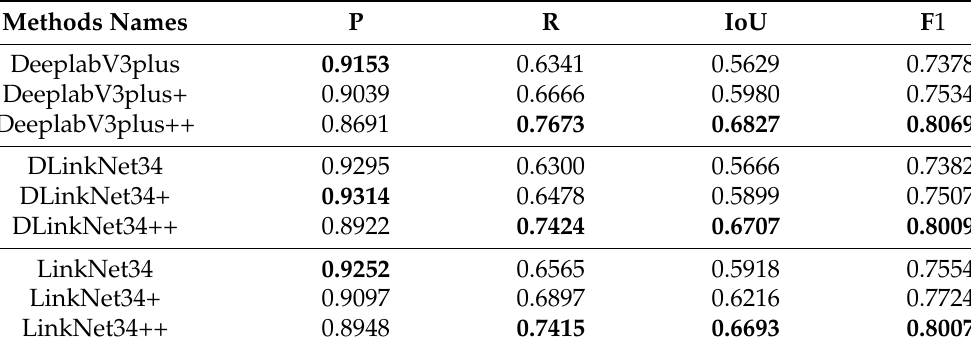
Table 2. Comparative quantitative Evaluation Among Different Methods for Road Detection on our dataset. It should be noted that the results are the average performance of all images in the test set. With the best results marked in